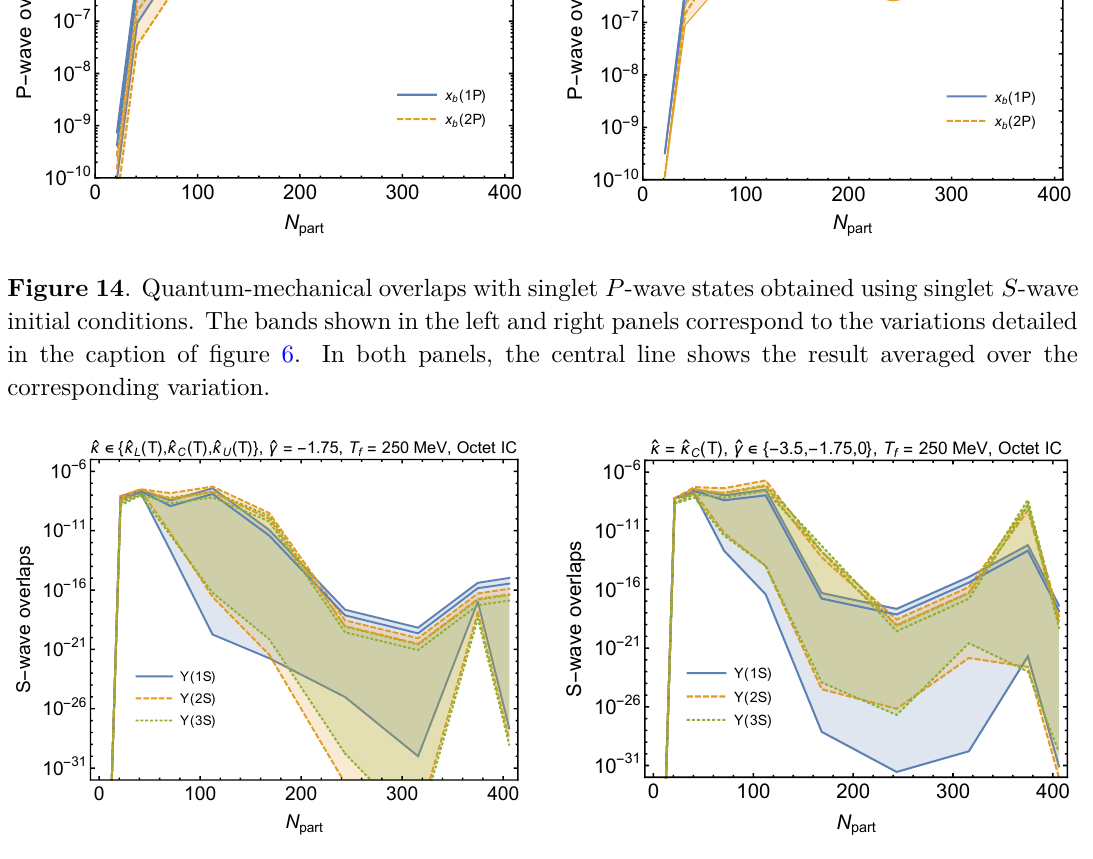
Figure 15 . Quantum-mechanical overlaps with singlet S -wave states obtained using octet P -wave initial conditions. The bands shown in the left and right panels correspond to the variations detailed in the caption of figure 6. In both panels, the central line shows the result averaged over the corresponding